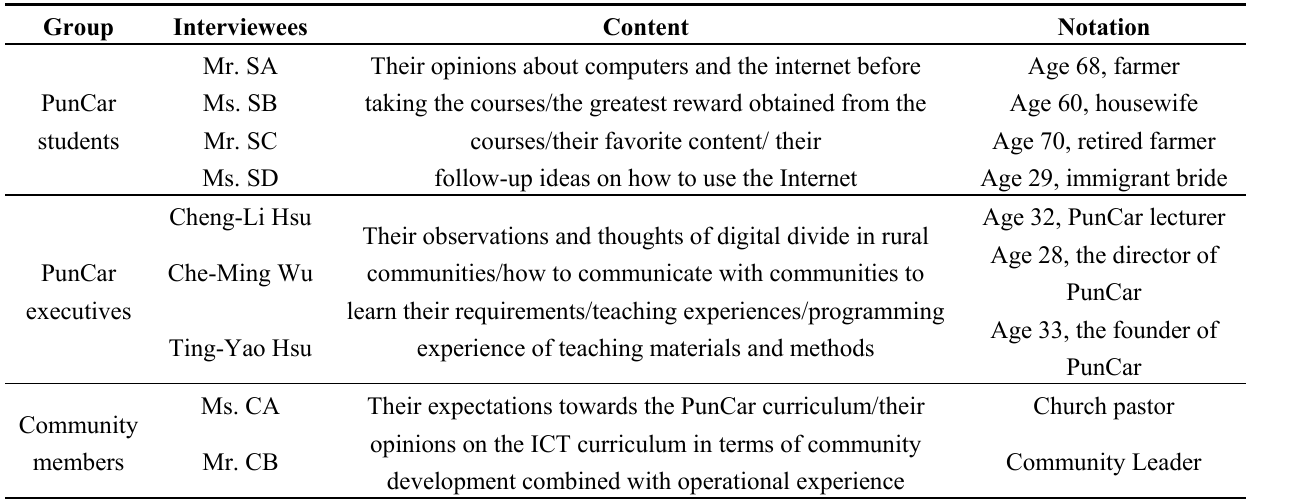
Table 2. List of